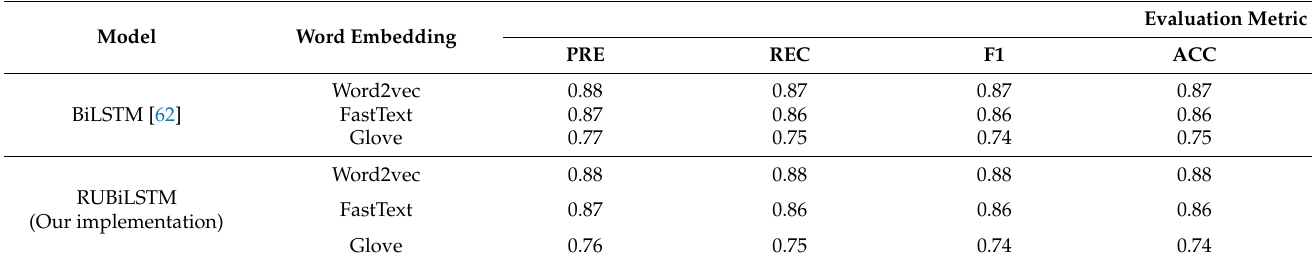
Table 7. Sentiment analysis of IMDB Movie Reviews